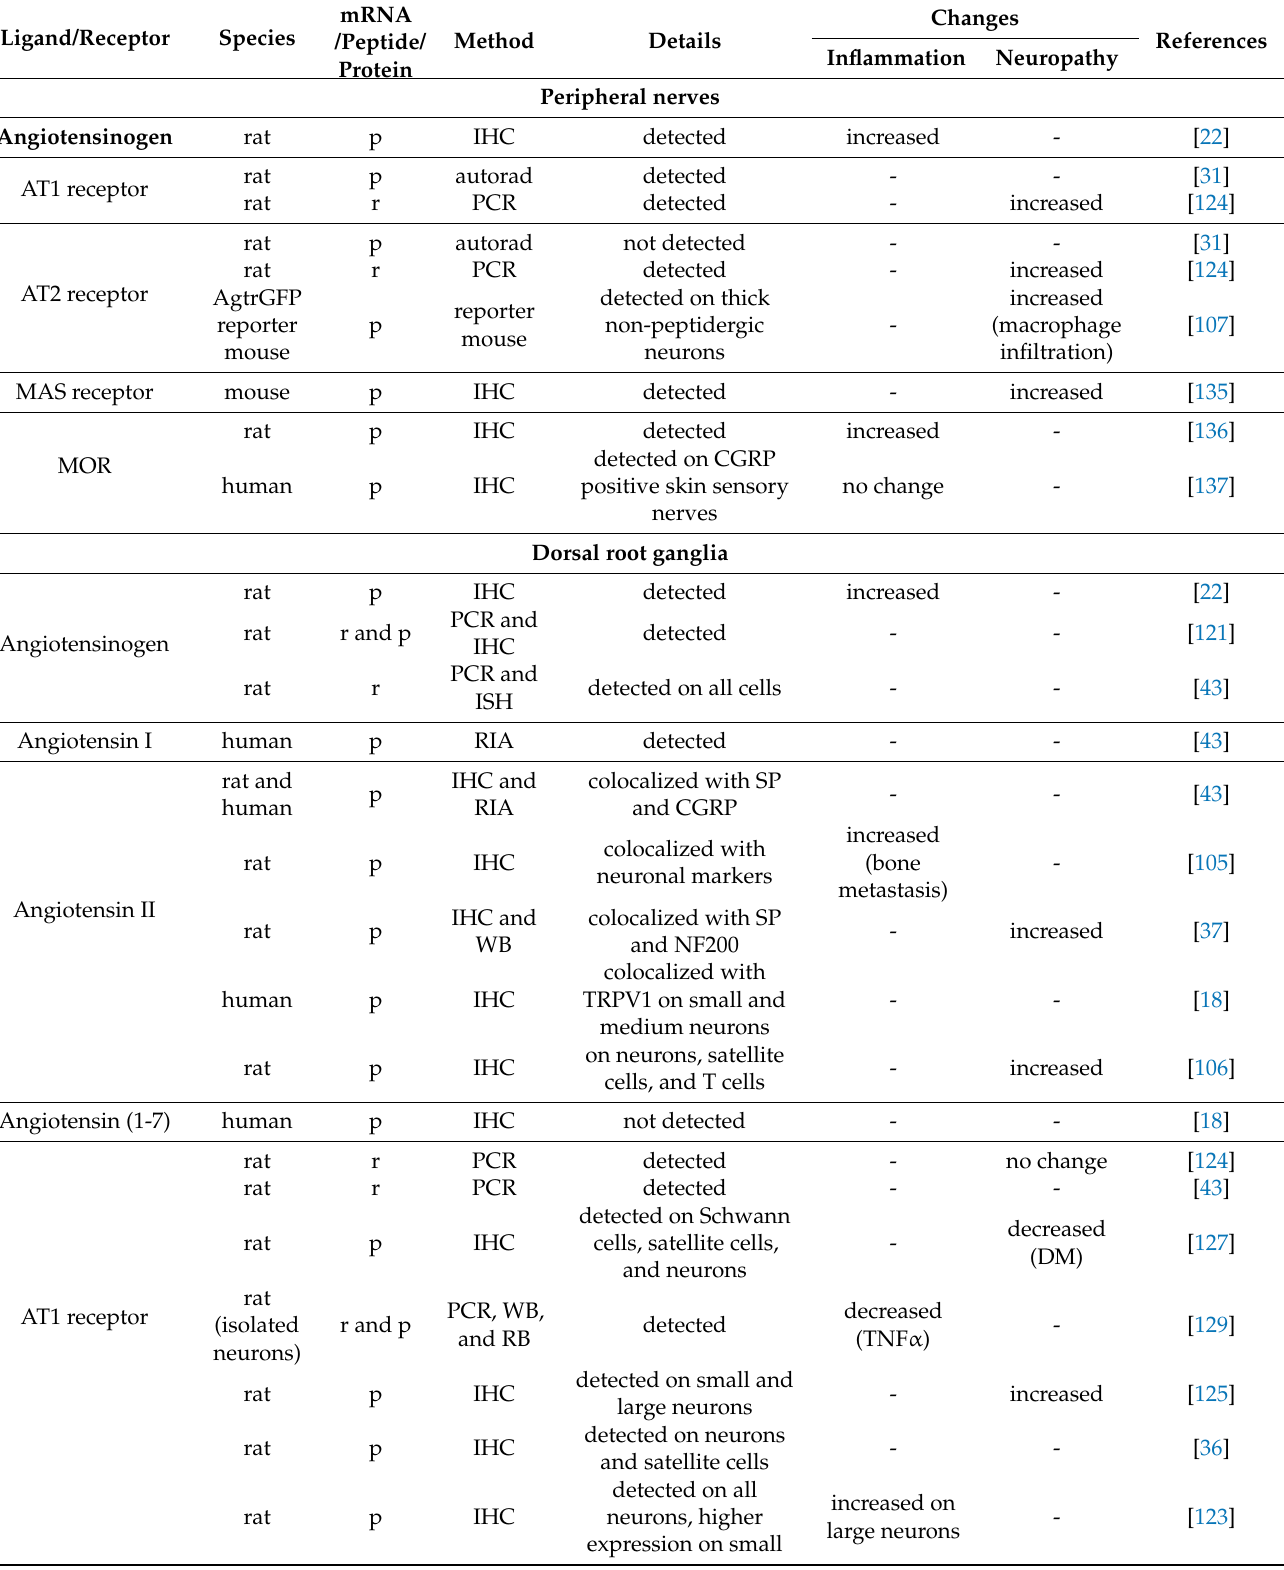
Table 1. Neuroanatomical distribution of ligands and receptors in the renin–angiotensin system with importance in pain transmission and the µ -opioid receptor